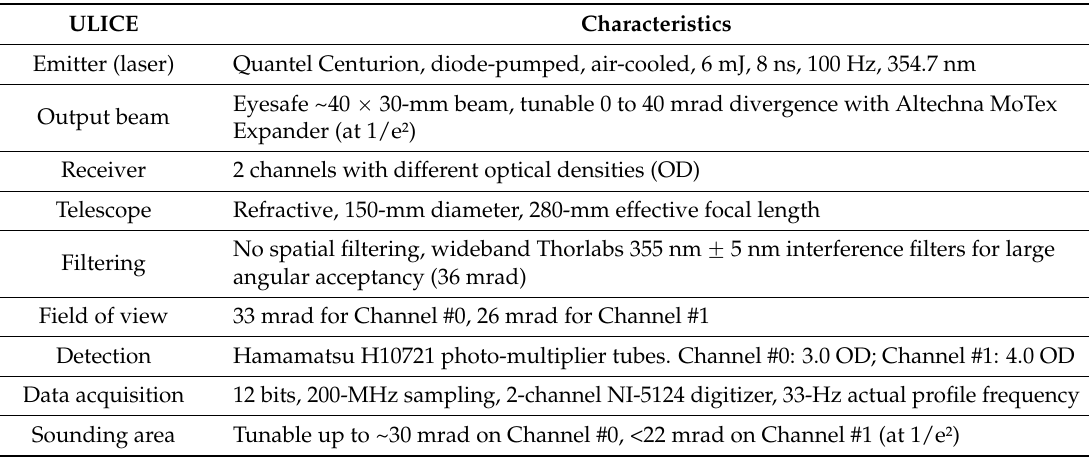
Figure 2. Autonomous payload (~80 kg) implemented on an ultra-light aircraft, including ( a ) the Ultraviolet LiDAR for Canopy Experiment (ULICE). The other instruments are also onboard: ( b ) a Tetracam ADC (Agricultural Digital Camera) air camera is used to get the photosynthesis activity index (Normalized Difference Vegetation Index (NDVI)) images over the forest canopy; the ancillary positioning instrument, called the MTi-G system, consists of a Global Positioning System (5-m accuracy) and an inclinometer (0.7° accuracy); ( c ) a Vaisala PTU-300 pressure/temperature/relative humidity probe is used for altitude correction and control of the tropical high humidity conditions that could affect the transmittance of LiDAR optics. Table 2. Summary of the ULICE characteristics.